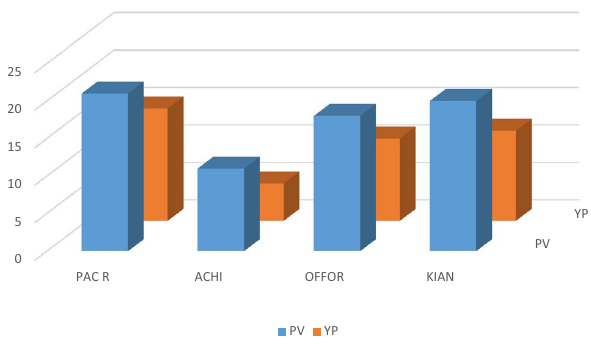
Fig. 2 Flow properties of the water based mud for each viscosifiers at 80